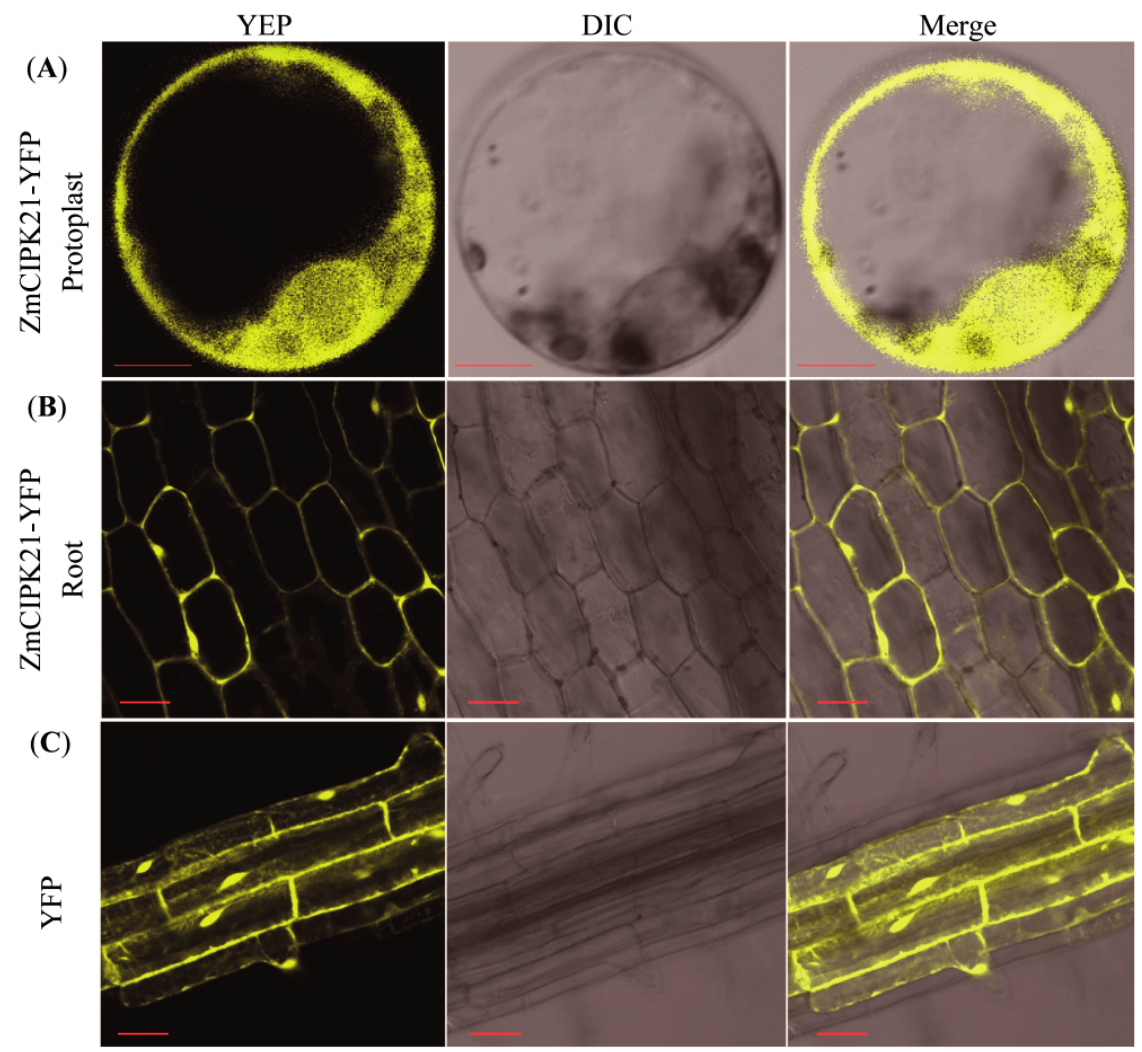
Figure 4. Localization of ZmCIPK21 in Arabidopsis roots and protoplast of leaves. ( A ) The protoplasts of the 35S:ZMCIPK21-YFP plants; ( B ) The 35S:ZmCIPK21-YFP plants roots expressing YFP -fused ZmCIPK21 ; ( C ) Arabidopsis roots expressing 35S:YFP . 200× magnification. Scale bar = 10 μ